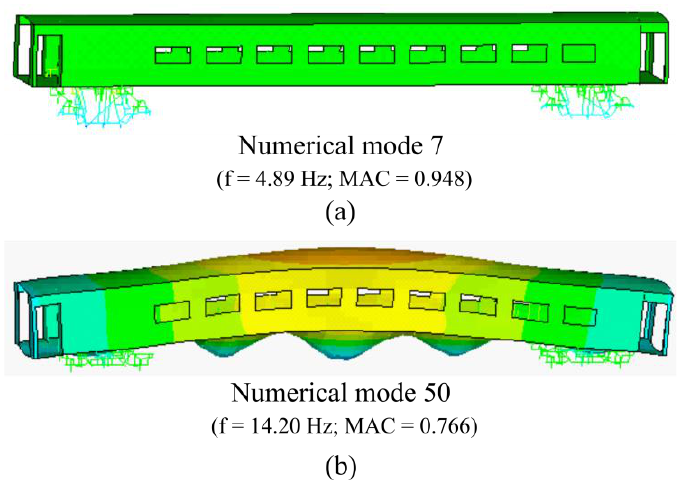
Figure 11. Numerical vibration modes likely to pair with ( a ) experimental mode 1C, and ( b ) exper- imental mode 5C.